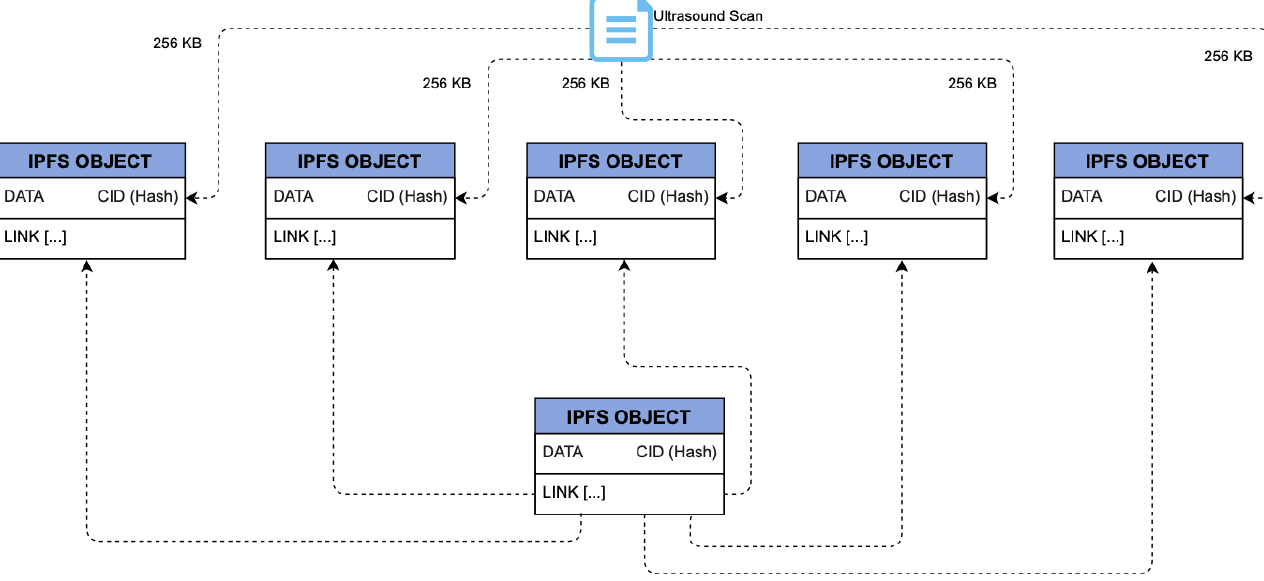
Figure 21. IPFS storage process.